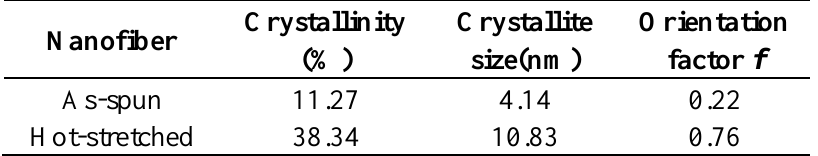
Table 1. Percent crystallinity and crystallite size obtained from X -ray